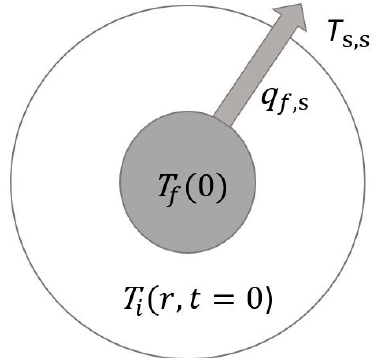
Figure 1. Quasi-steady-state thermal process in the insulated district heating (DH) pipe. The fluid temperature before time zero, i.e., the time of shutdown, is denoted T f 0 (K); the corresponding temperature in the surrounding insulation is denoted T i ( r , t = 0 ) (K), while the immediately surrounding soil temperature is T s , s . The heat loss is q f , s (W/m).